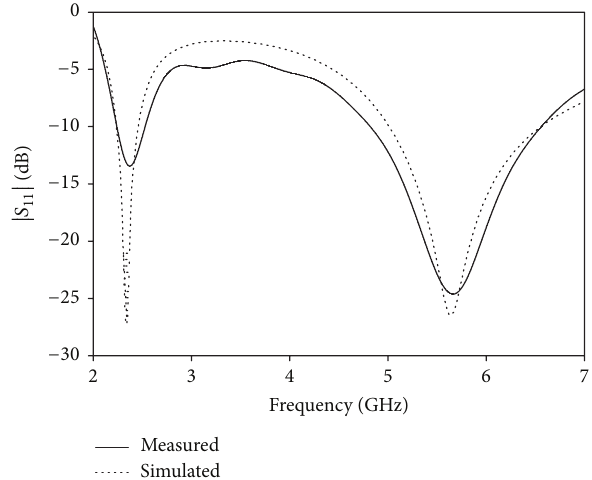
Figure 9: Measured and simulated reflection coefficient of the proposed dual-band